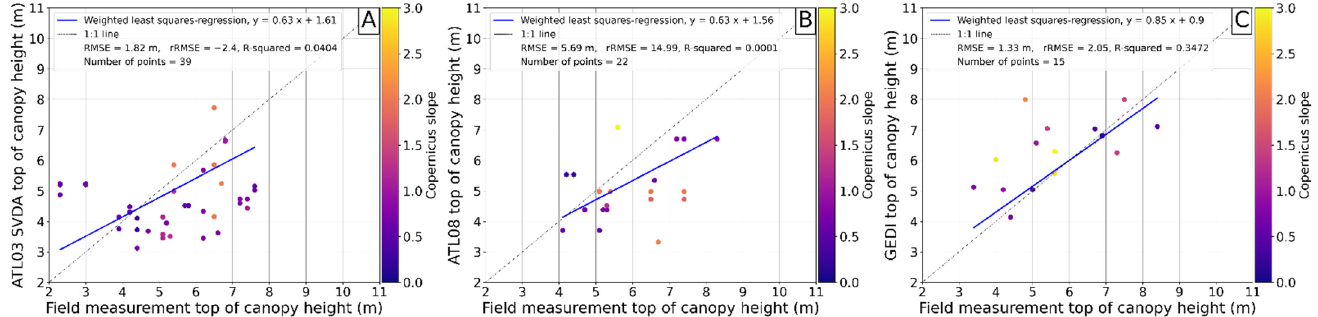
Figure 9. Field measurements ( n = 55) intersection with ATL03 SVDA based on ATL03 canopy height measurements as described in Sections 3.6.1 and 3.6.2 within a buffer of 10 m ( A ). ( B ): Field measurements intersection with ATL08 within a buffer of 30 m. We note that one canopy height field measurements of 5.4 m resulted in an ATL08 canopy height of 31.24 m and we do not show this outlier to keep axes constant between the plots. ( C ): Field measurements intersection with GEDI within a buffer of 30 m. Blue line shows the weighted least squares regression, where the inverse of canopy height difference between GEDI/ICESat-2 (ATL03 SVDA and ATL08) and field measurements were used as weights. rRMSE shows the relative RMSE (RMSE/mean of the height differences between ATL and field measurements).